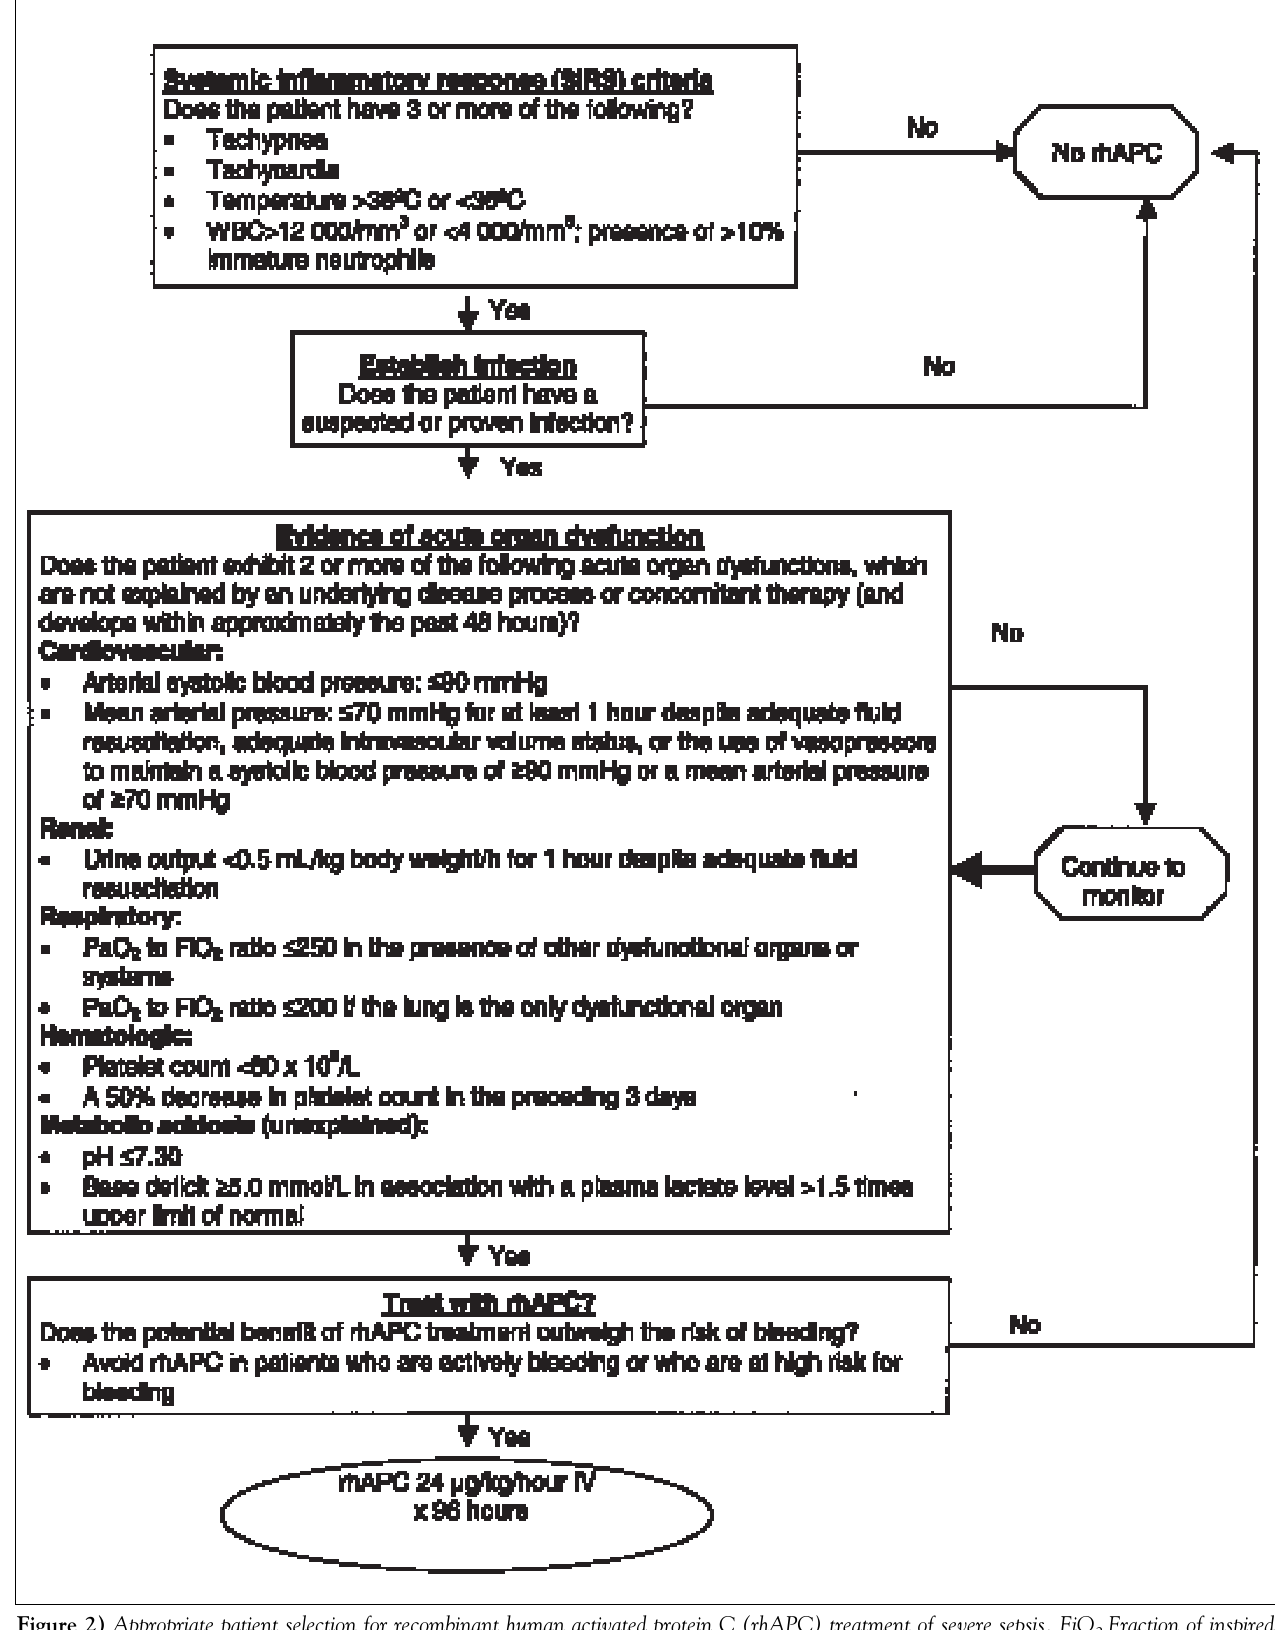
Figure 2) Appropriate patient selection for recombinant human activated protein C (rhAPC) treatment of severe sepsis. FiO oxygen;